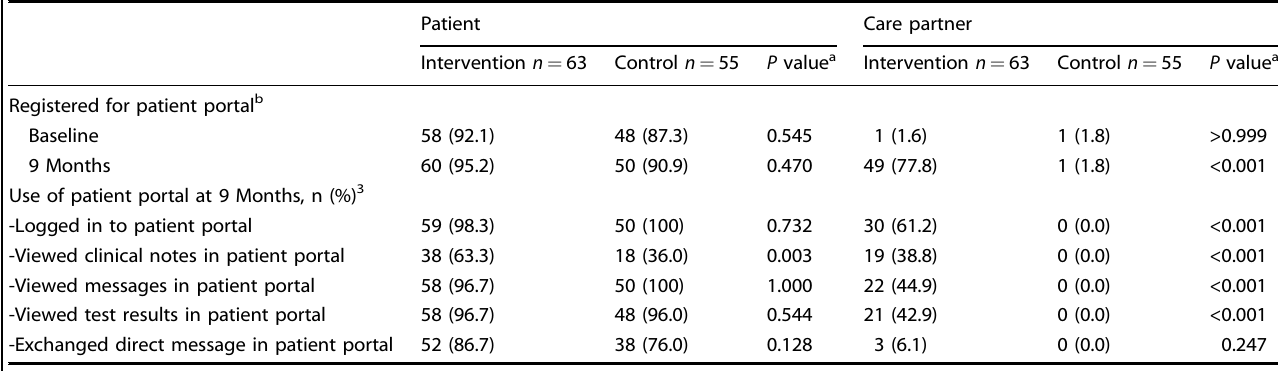
Table 2. Effects on patient and care partner registration and use of the patient